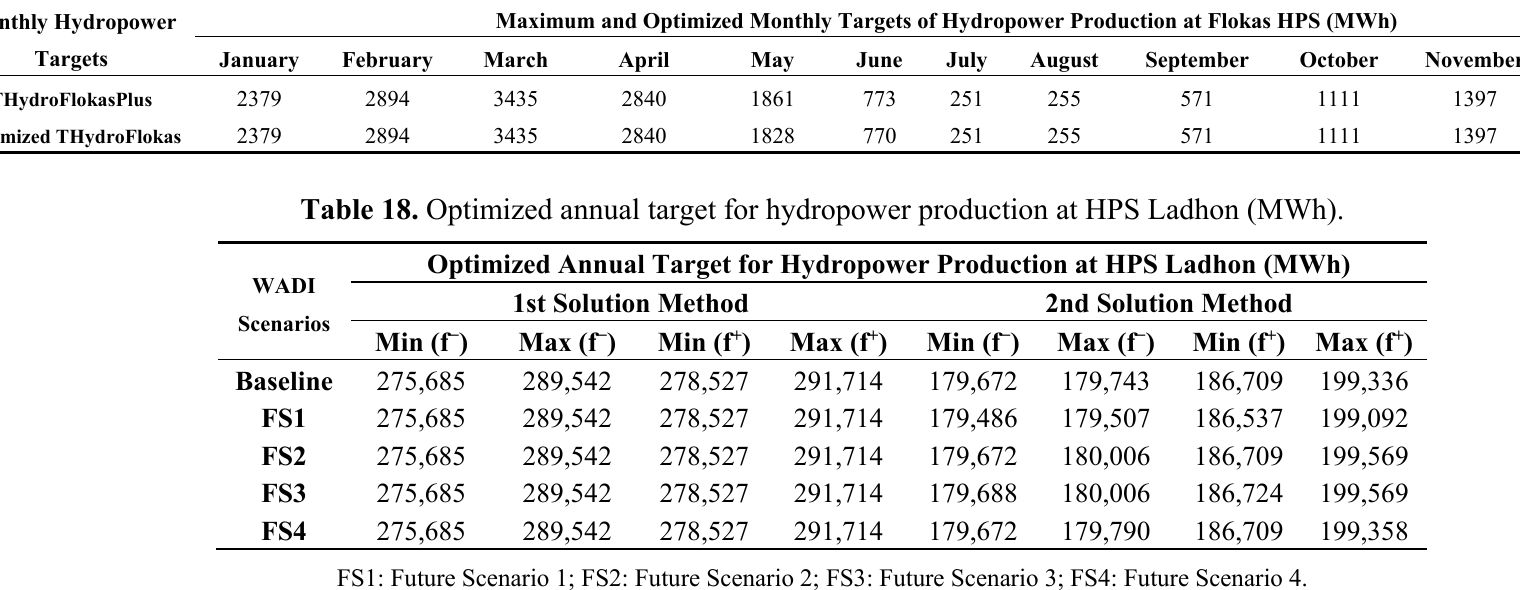
Table 17. Maximum allowable (THydroFlokasPlus) and Optimized (Optimized THydroFlokas) monthly targets of hydropower production at Flokas HPS (MWh).